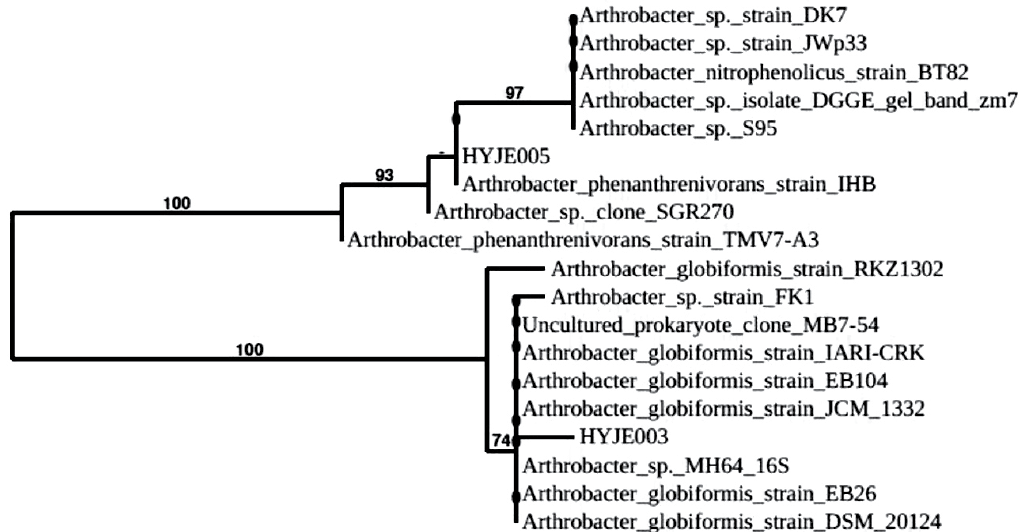
Fig. 8. Phylogenetic tree of Arthrobacter sp. HYJE003 and HYJE05 based on 16S rRNA sequences. Each branch represents bootstrap values ( ≥ 50%) for 1000 replications from pairwise neighbor